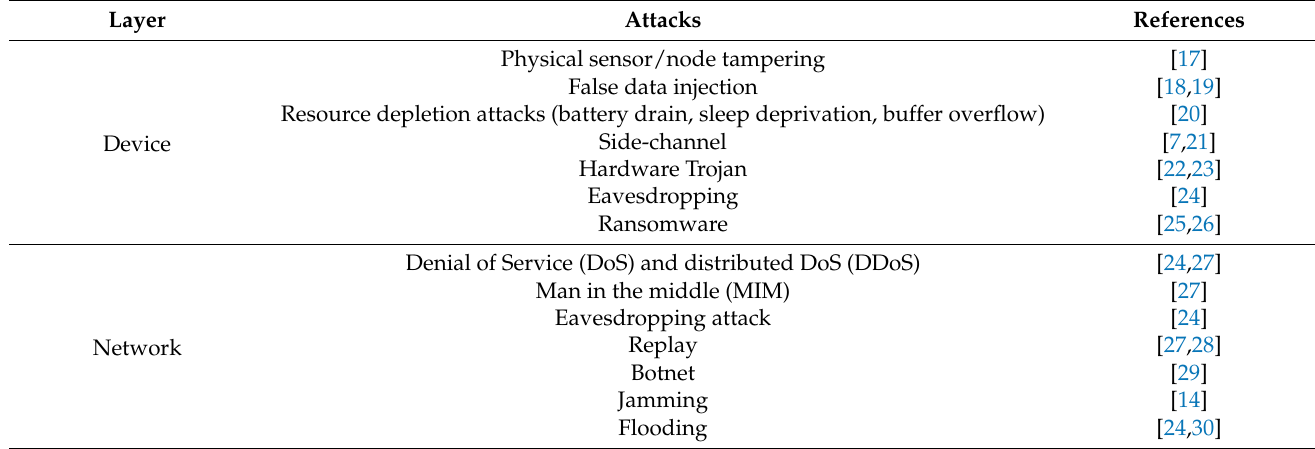
Table 2. The attack targeted devices and networks in